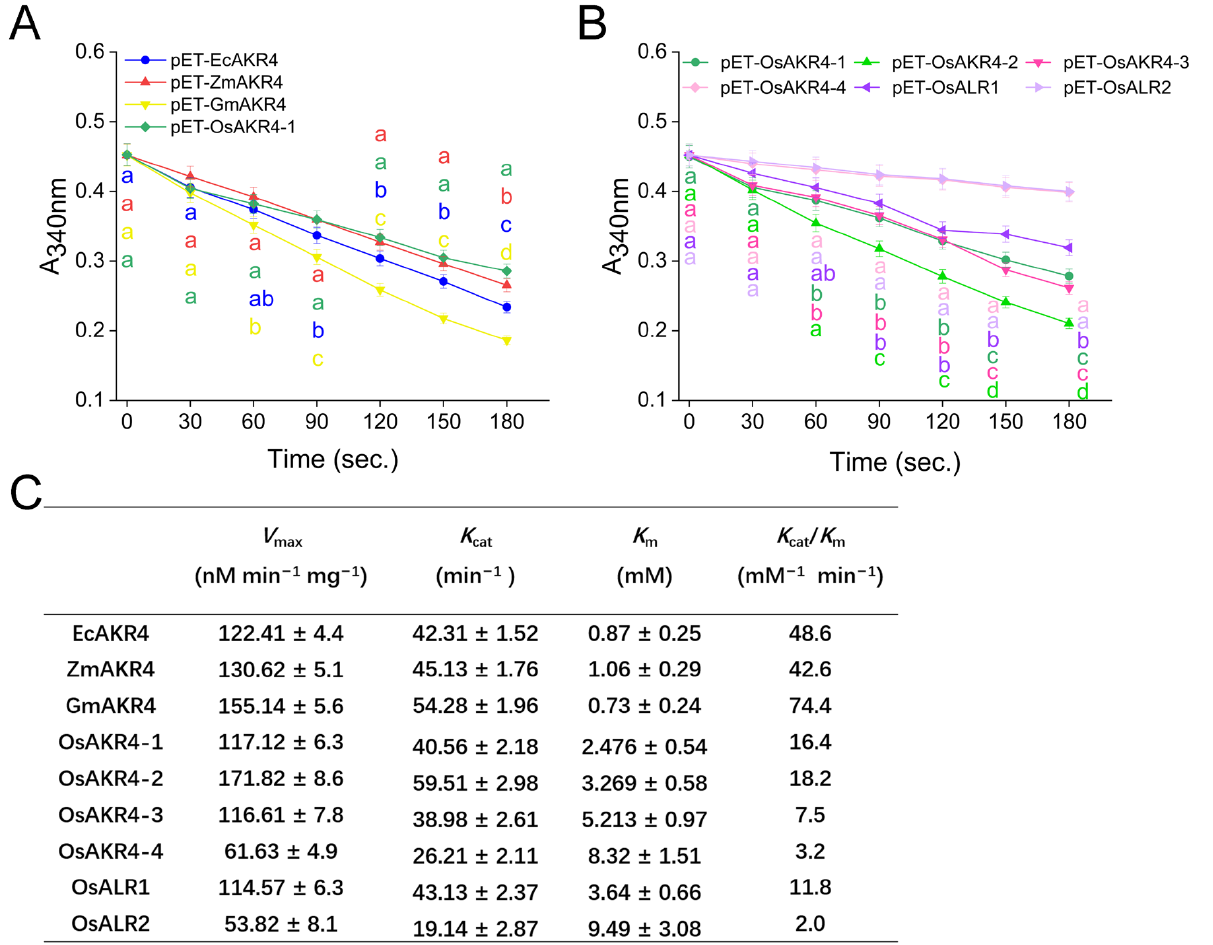
Figure 3. Activity of purified AKR proteins against benzaldehyde in vitro. ( A , B ) Enzyme activity of EcAKR4, ZmAKR4, GmAKR4, and OsAKR4-1 ( A ) along with OsAKRs ( B ) against 10 mM benzaldehyde. ( C ) Kinetic parameters of benzaldehyde metabolism by AKR enzymes. Data are mean ± standard deviation, n = 3.